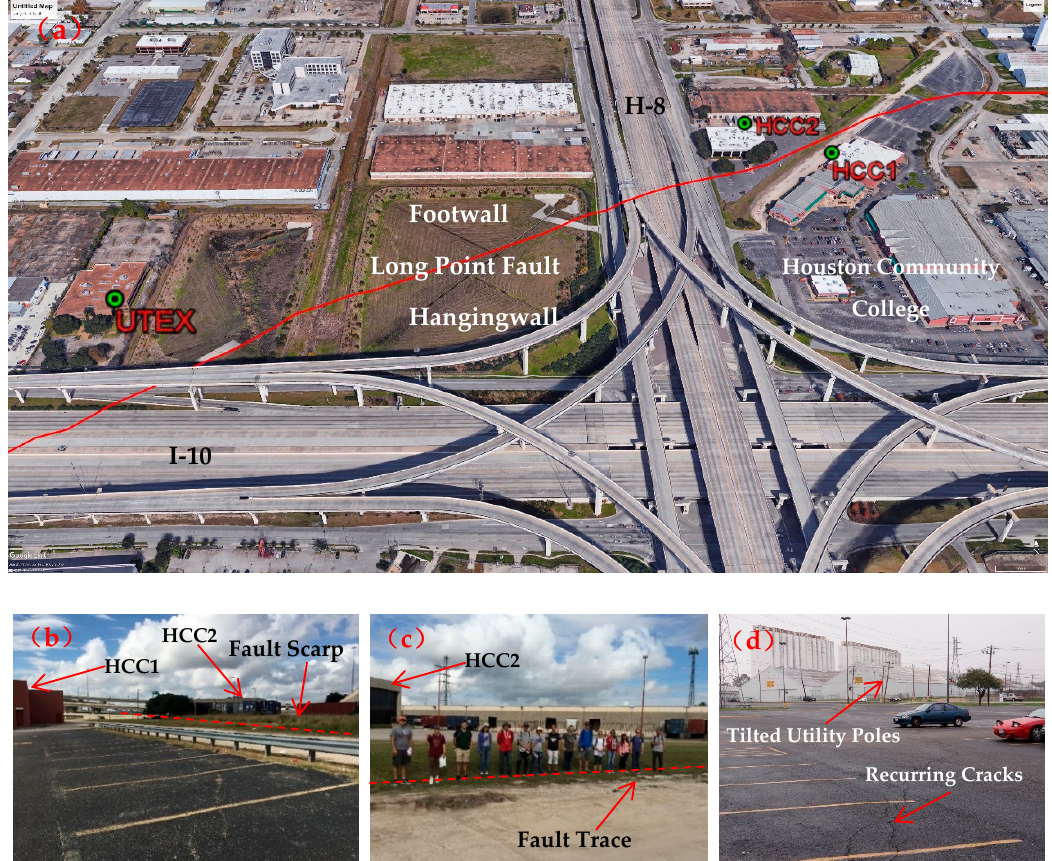
Figure 3. ( a ) The fault trace of the Long Point Fault near the intersection of Interstate Highway 10 (I-10) and Texas State Highway 8 (H-8) (Google Image); ( b ) the fault scarp of the Long Point Fault between GPS stations HCC1 (hangingwall side) and HCC2 (footwall side); ( c ) the height of the fault scarp is approximately 1.5 m at this site; ( d ) randomly tilted utility poles and recurring cracks on the pavement in the parking lot near the fault scarp. These photos were taken in October 2017.